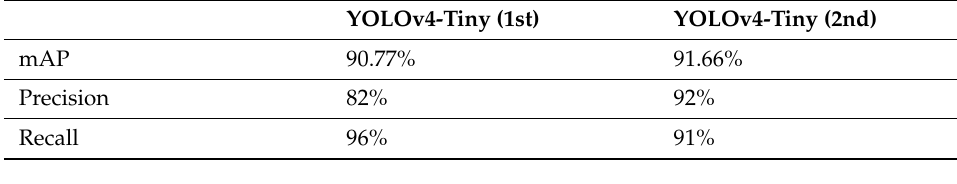
Table 8. Performance of the 1st and the 2nd version of YOLOv4-Tiny.